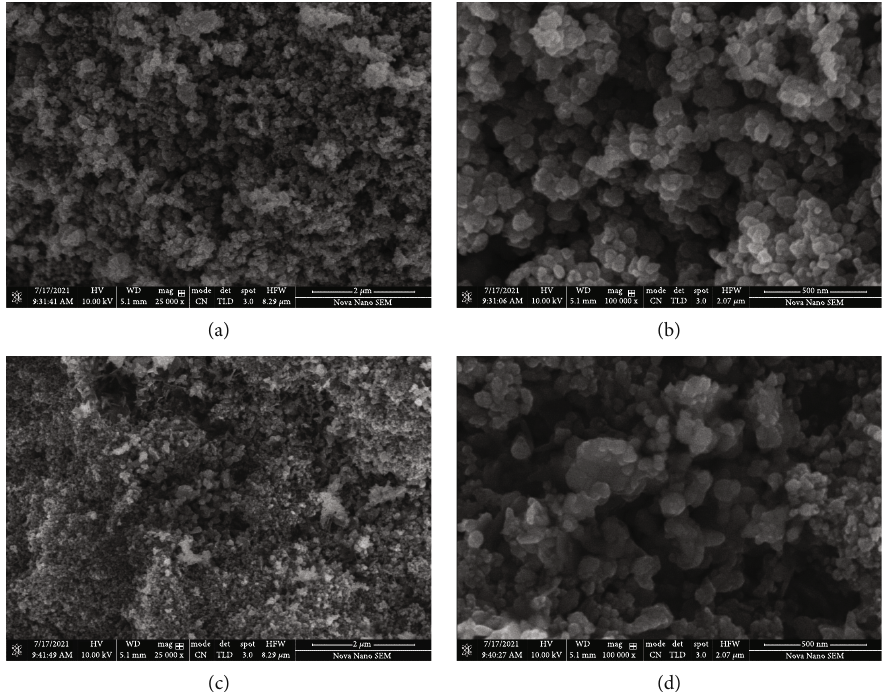
Figure 4: FESEM topographical analysis (surface view) of (a, b) pure ZnO and (c, d) Mn-doped ZnO at 25kx and 100kx magni fi cation scales,